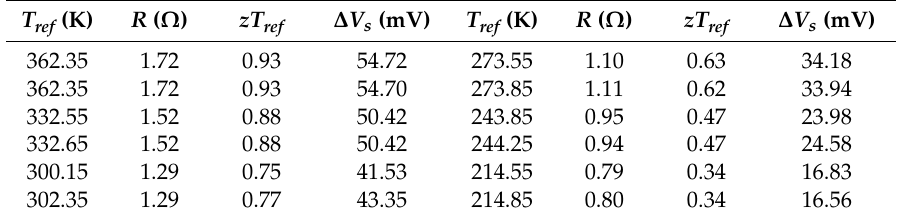
Table 2. Peltier module a.1: p - n series resistance, the figure of merit, and Seebeck voltage ( I = 41 mA).